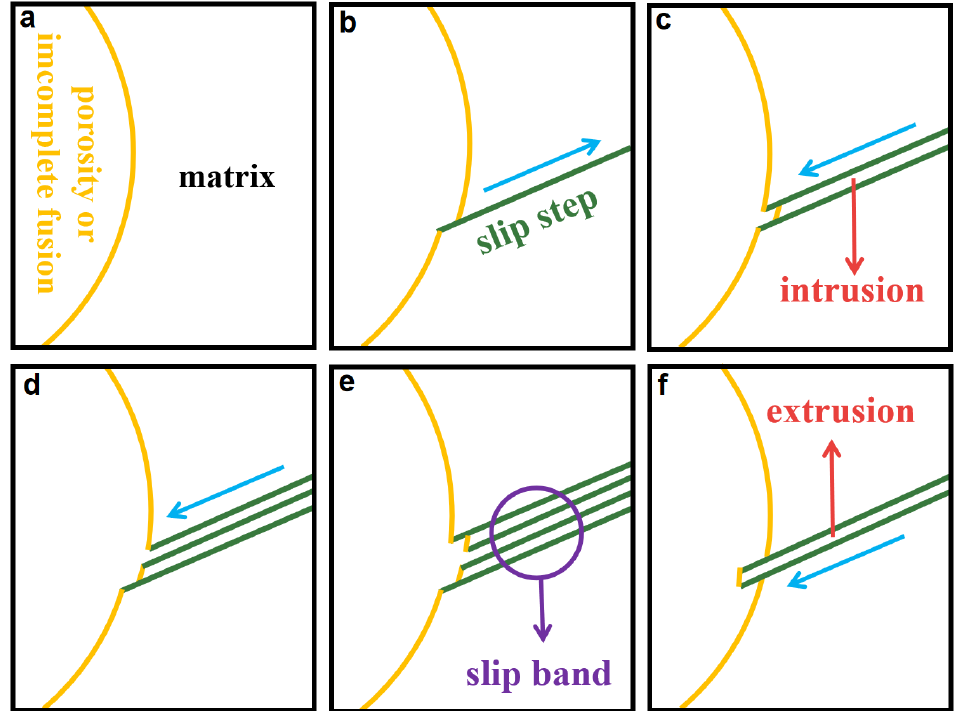
Figure 15. Fatigue crack initiation caused by porosity and incomplete fusion: ( a ) original appearance of porosity and incomplete fusion; ( b ) slip steps; ( c ) intrusion; ( d ) shearing stress on the same slip band becomes larger; ( e ) slip band; ( f ) extrusion.